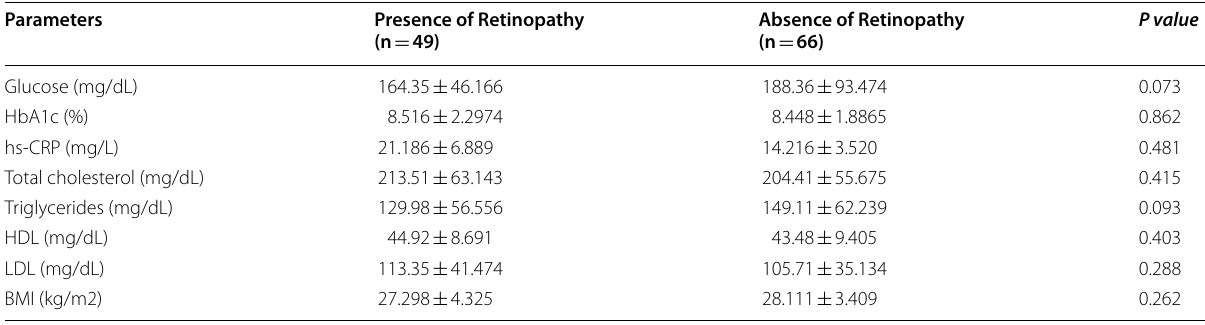
Independent t-test was used